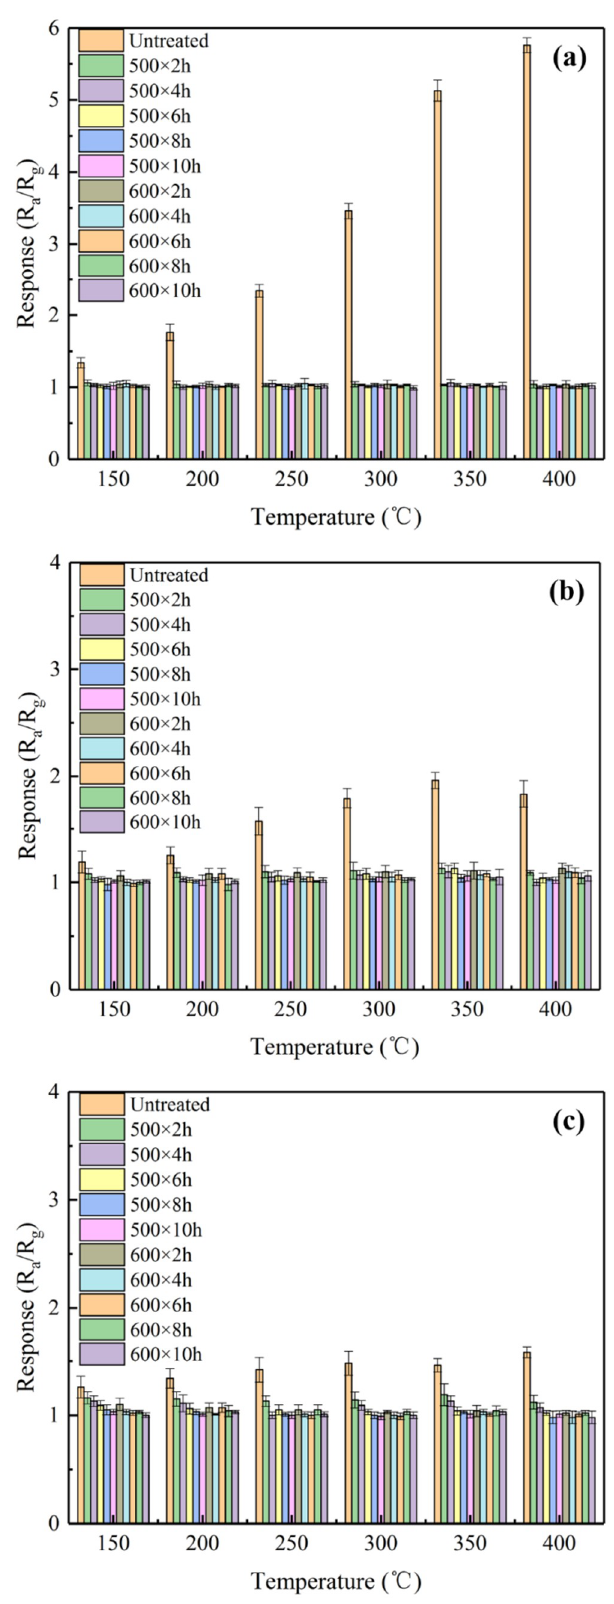
Figure 10. The responses of various sensors at a series of temperatures to ( a ) ethanol at 100 ppm, ( b ) acetone at 100 ppm, and ( c ) benzene at 100 ( b ) acetone at 100 ppm, and ( c ) benzene at 100 ppm.